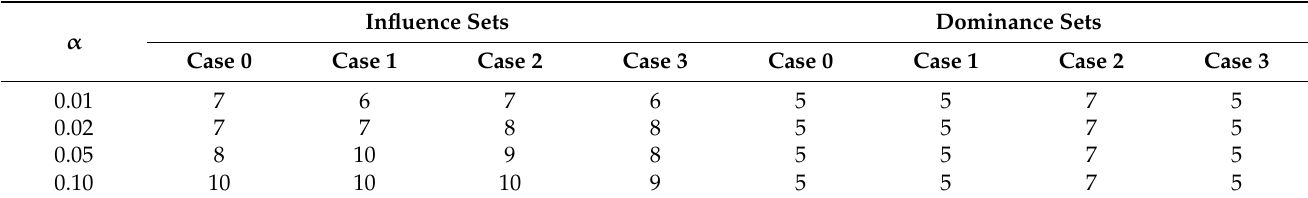
Table 17. The Numbers of the Sets A S, j and A D, j j ∈ {1, 2, . . . , 14} for Considered Study Cases.